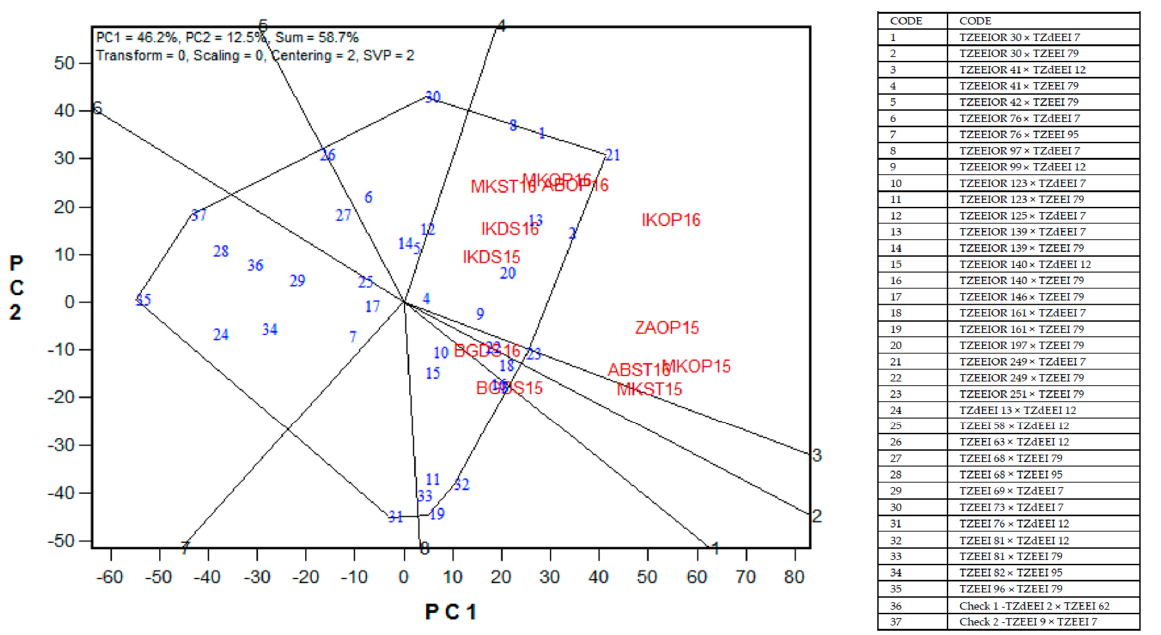
Figure 2. A “which-wins-where or which-is-best-at-what” genotype plus genotype by environment biplot of 35 selected extra-early maturing PVA maize hybrids plus two hybrid checks across stress and non-stress conditions in Nigeria, 2014–2016. ABOP16 = Abuja optimal, 2016; ABST16 = Abuja Scheme 2016. BGDS15 = Bagauda drought stress, 2015; BGDS16 = Bagauda drought stress, 2016; IKDS15 = Ikenne drought stress, 2015; IKDS16 = Ikenne drought stress, 2016; IKOP16 = Ikenne optimal, 2016; MKOP15 = Mokwa optimal, 2015; MKOP16 = Mokwa optimal, 2016; MKST15 = Mokwa Striga -infested, 2015; MKST16 = Mokwa Striga -infested, 2016; ZAOP15 = Zaria optimal, 2015.